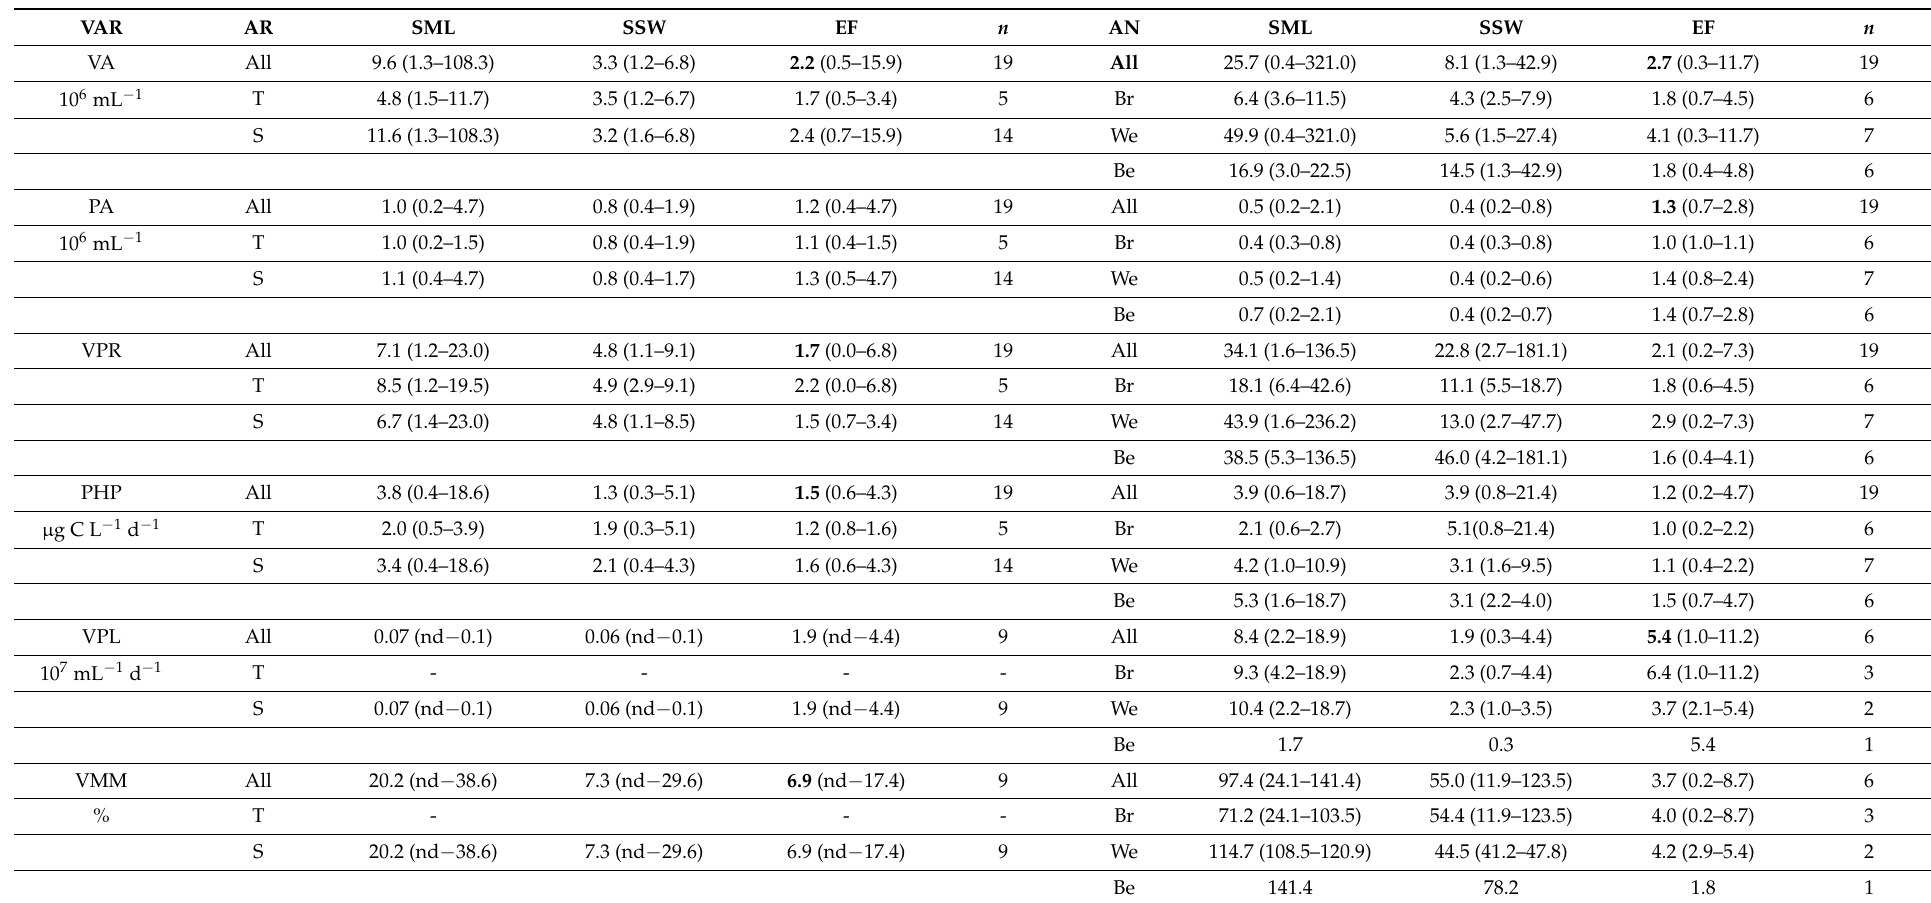
Table 2. Mean, minimal, and maximal values of viral and microbial variables of the surface microlayer (SML) and subsurface water (SSW) of the Arctic (AR; T: transect of Greenland Sea; S: Svalbard; ATOS 1) and Antarctic (AN; Br: Bransfield strait; We: Weddell Sea; Be: Bellingshausen Sea; ATOS2) seawaters. EF: enrichment factor, in bold significant values ( p < 0.05) different than 1. VA: viral abundance; PA; prokaryote abundance; VPR: virus prokaryote ratio; PHP: prokaryotic heterotrophic production; VPL: viral lytic production; %VMM: percentage of virus-mediated mortality (lytic infected cells); %Lysogeny: percentage of lysogenic infected cells; RLC: rate of lysed cells; RLC_C: rate of carbon released from lysed cells; HNF and PNF: heterotrophic and phototrophic nanoflagellates; %HNF < 5 µ m: percentage of HNF smaller than 5 µ m; n : number of values; nd: non-detected; -: no